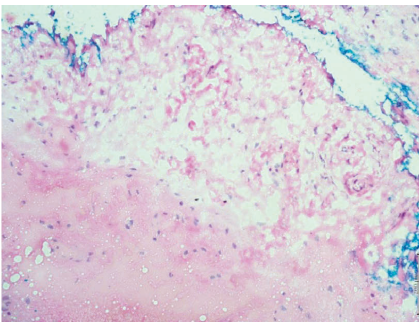
Figure 3: Possible tumoral cells similar to lymphocyte or stromal cells (Frozen Section, x200, H δ E).